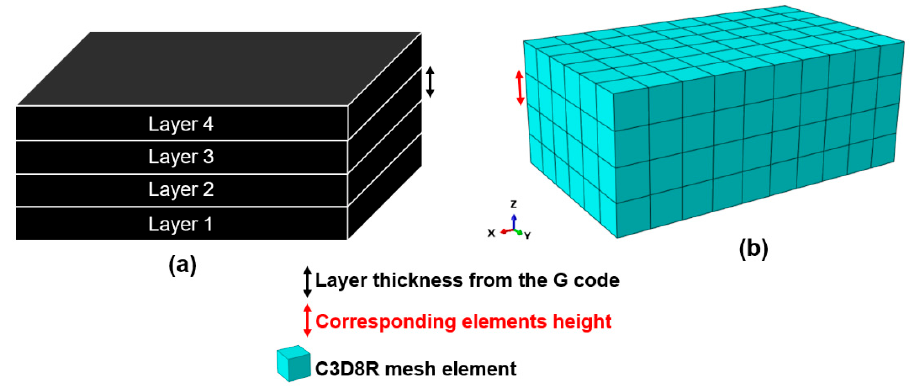
Figure 2. Correspondence between the layers heights ( a ) and the elements heights in ABAQUS mesh ( b ). Every layer from the G code contains different deposition trajectories.